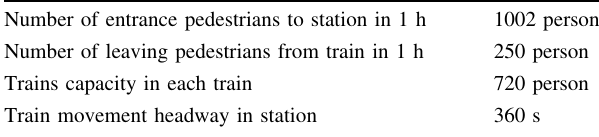
Table 4 Scenario 1